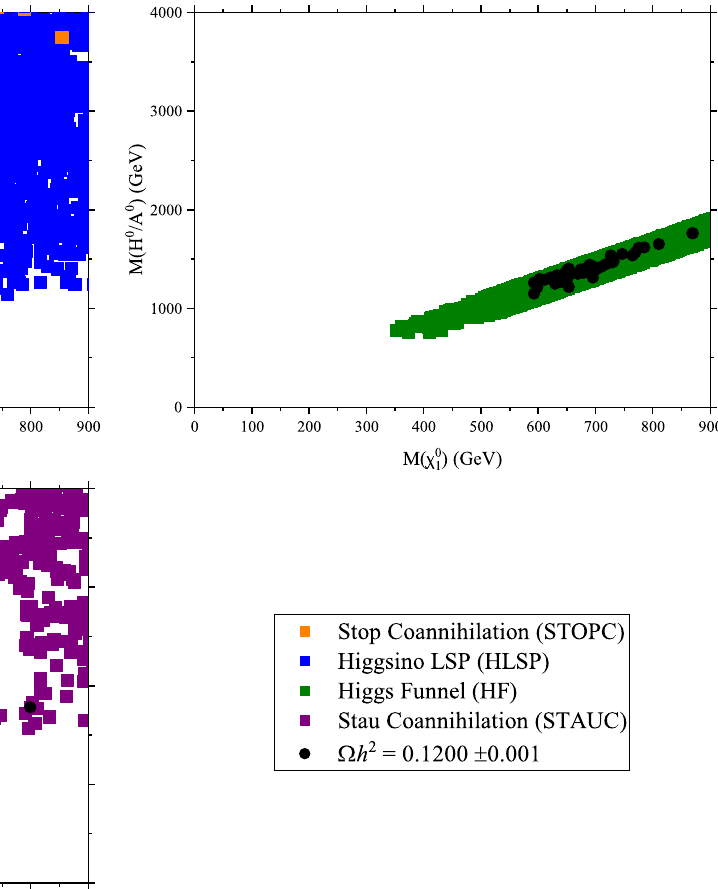
± 100 GeV on M ( H 0 / A 0 ) ; and (4) light stau